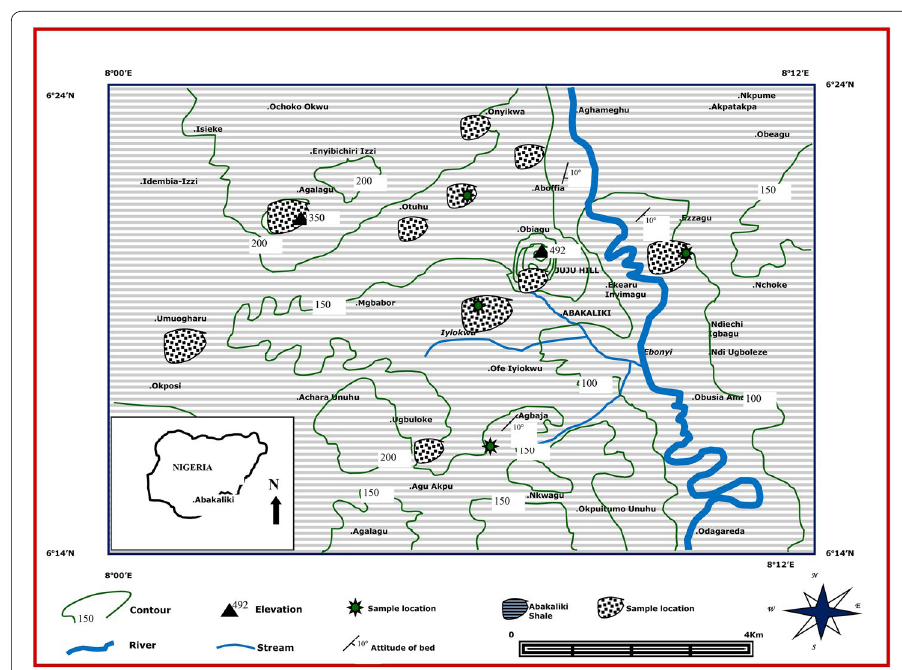
Fig. 2 Geological Map of Abakaliki Metropolis showing sample